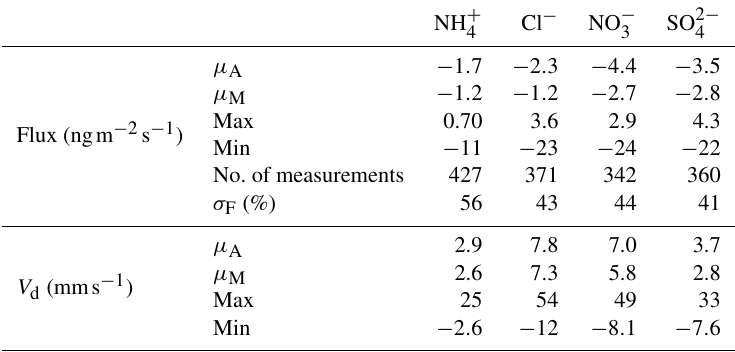
Table 3. Mean ( µ A ), median ( µ M ), maximum and minimum values of post-roughness sub-layer correction for fluxes and deposition veloc- ities ( V d ) for the water-soluble aerosols measured during the Amazon Tall Tower Observatory campaign. The number of fluxes calculated is quoted as number of measurements, and the median error in flux measurements as a percentage of flux values for each individual aerosol species ( σ F ) is included as part of the statistical summary for